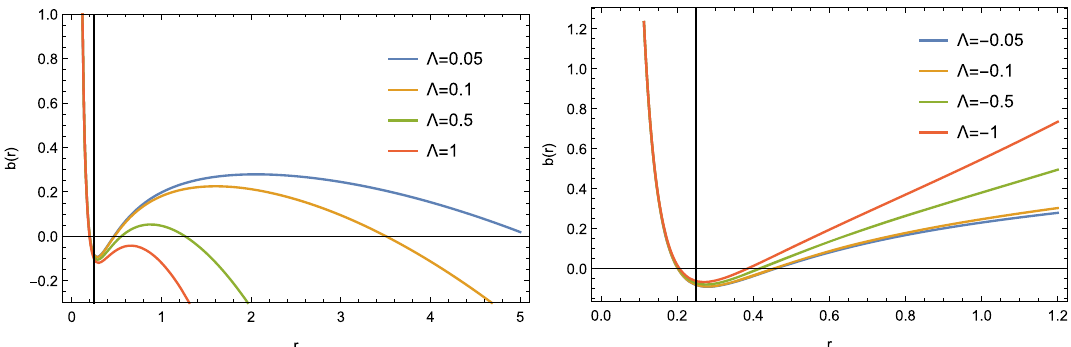
Fig. 7 The metric function b ( r ) while changing the cosmological constant, where we’ve set α = 1. The black vertical line represents the position of the divergence of the scalar field. The left plot represents dS spacetimes, while the right AdS